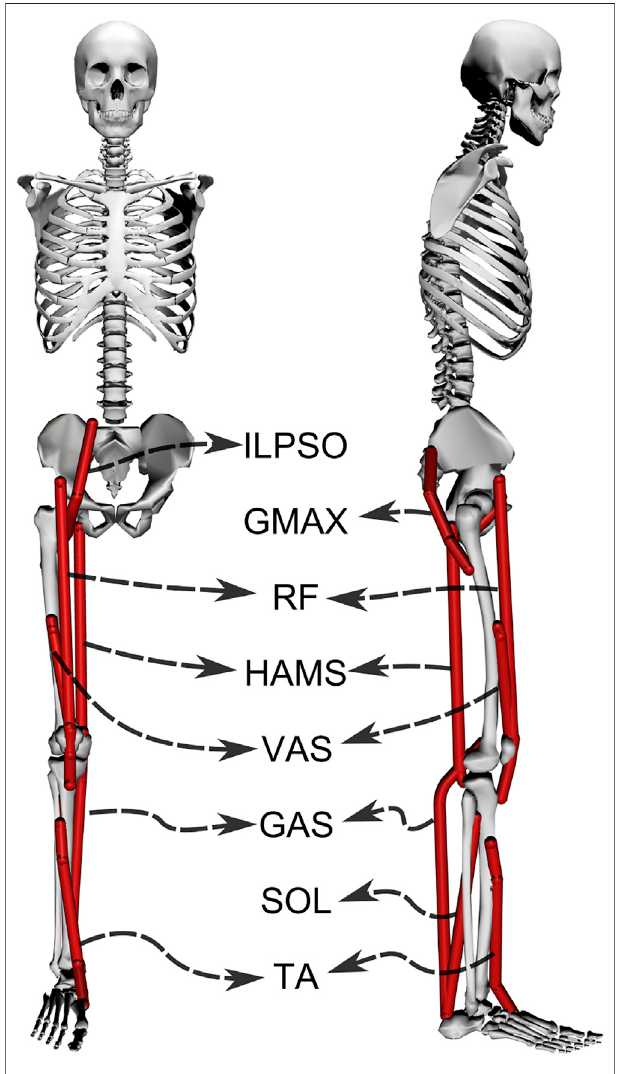
FIGURE 2 | A planar musculoskeletal model for sit-to-stand. The model ’ s musculotendon actuators (red lines) represents the major uniarticular and biarticular muscle groups that drive the sit-to-stand motion in the sagittal plane, i.e., iliopsoas (ILPSO),gluteus maximus (GMAX), biarticularrectus femoris(RF),biarticularhamstrings(HAMS),vasti(VAS),gastrocnemius(GAS), soleus (SOL), and tibialis anterior (TA). The model has three degrees of freedom distributed at the hip, knee and ankle joints.